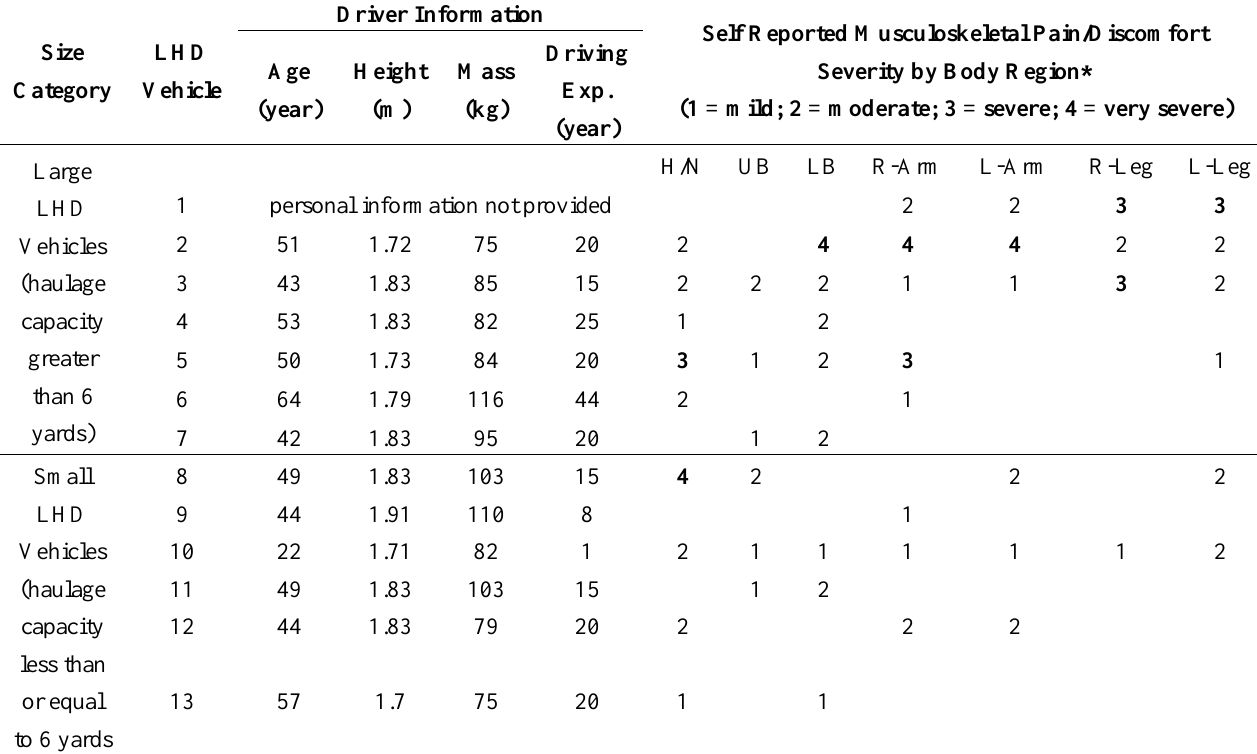
Table 1. LHD (load-haul-dump vehicle) operator characteristics along with self reported activity levels and work-related musculoskeletal pain/discomfort. Areas of severe and very severe pain/discomfort are